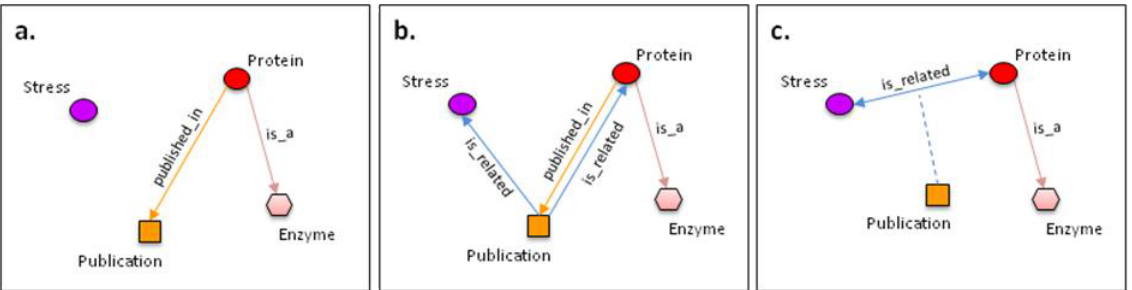
Figure 3: Three steps towards a protein-stress association network using the Ondex text mining plugin. a) Input data, b) Named Entity Recognition (NER) and c) from co-occurrence to weighted association